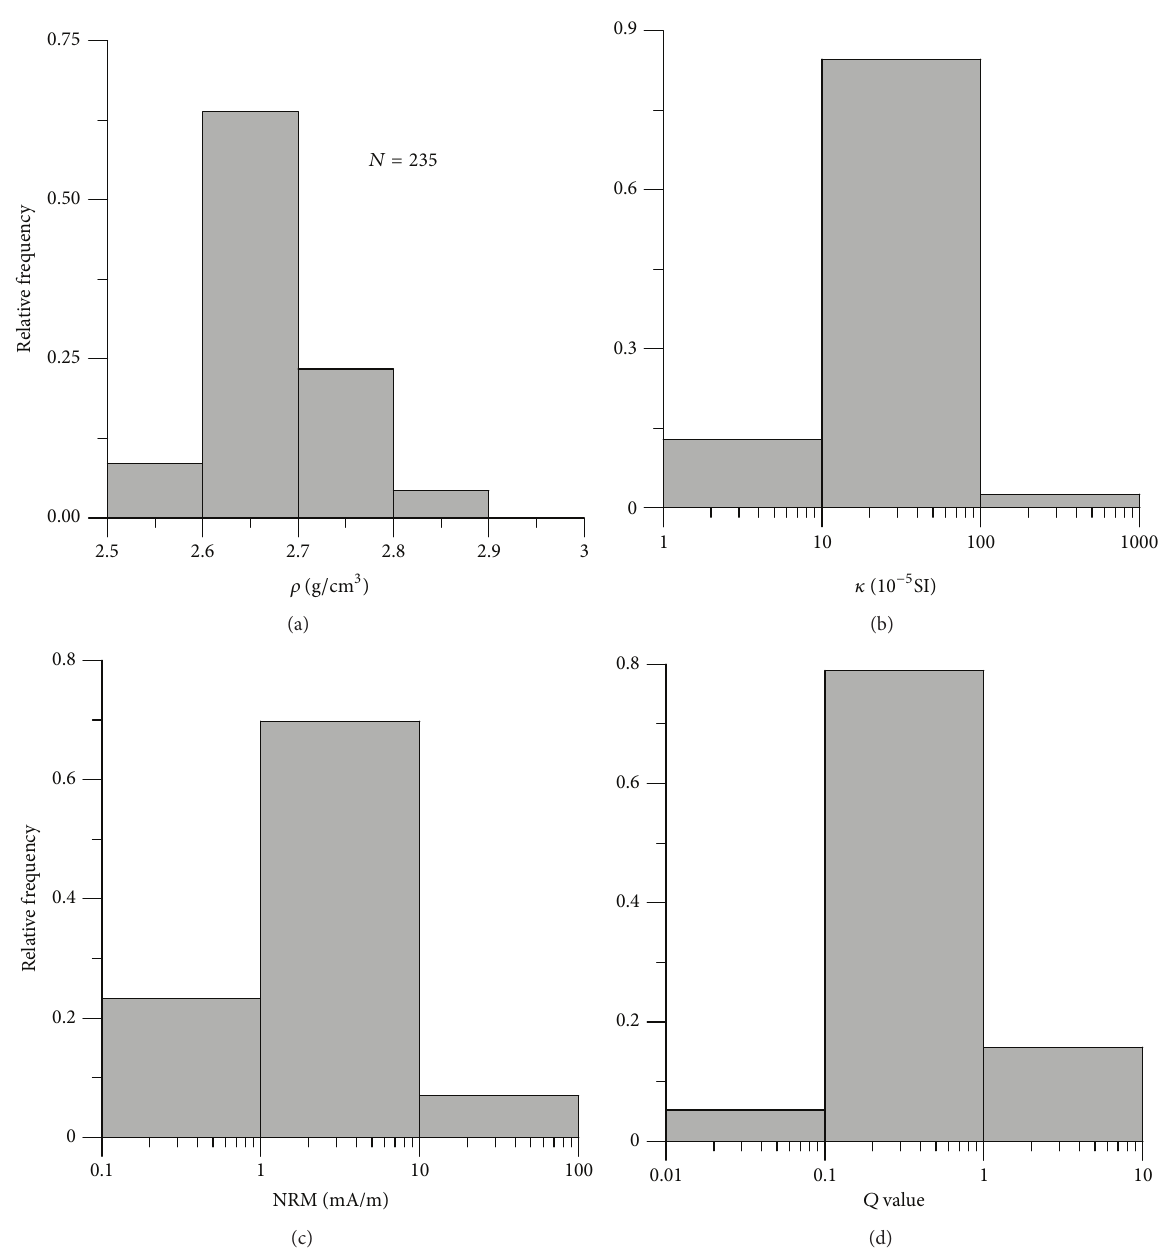
Figure 3: Histogram for (a) 𝜌 , (b) 𝜅 , (c) NRM, and (d) 𝑄 of sedimentary rock samples.